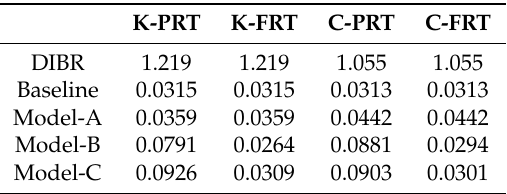
Table 4. Inference time of five models (unit: second).